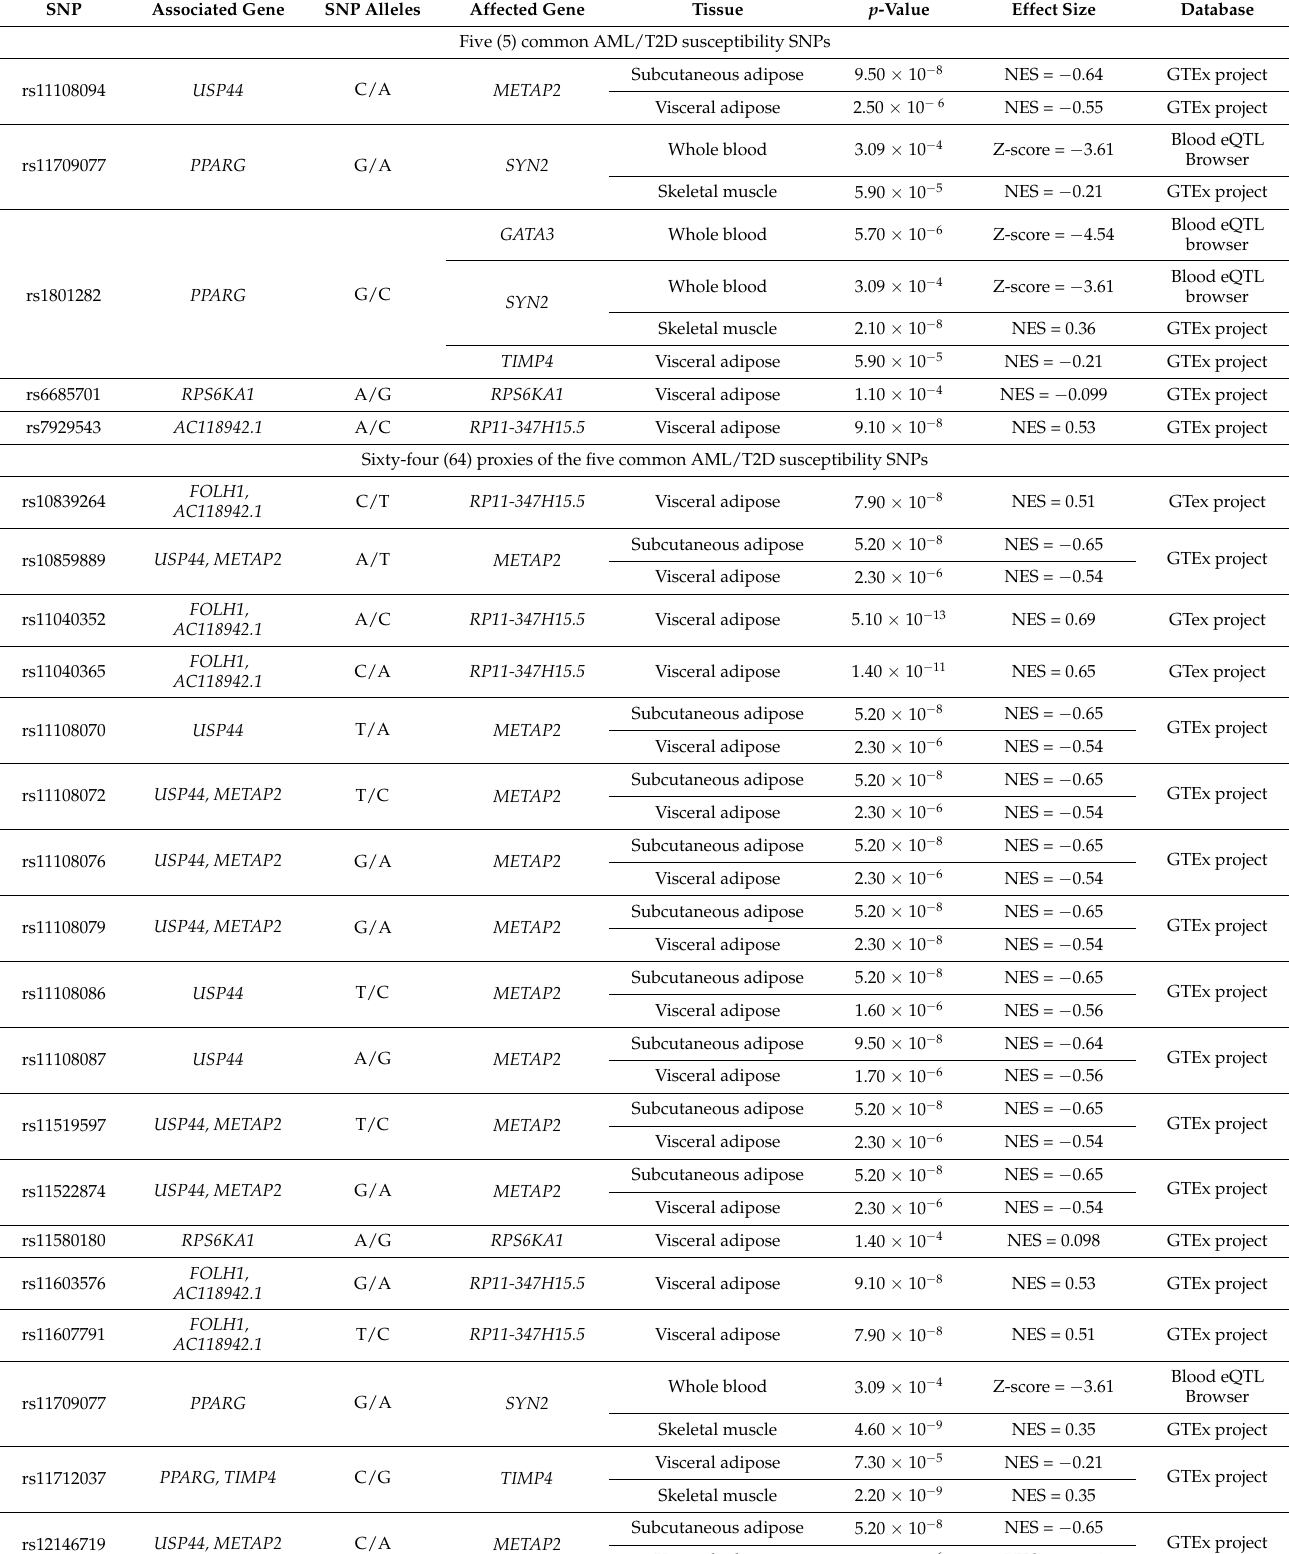
Table 2. eQTL associated with the five common disease susceptibility SNPs described in AML and/or T2D target tissues, as well as with their 64 proxies, as deposited in the GTEx project and Blood eQTL Browser. The SNP ID, SNP alleles, associated and affected genes and tissue(s), as well as corresponding p -values and the effect sizes, are